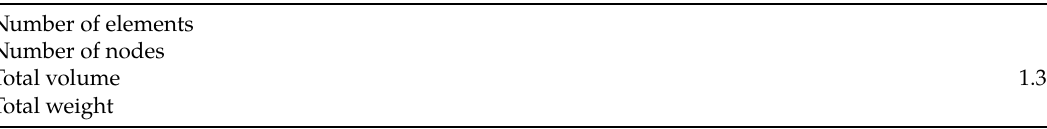
Table 1: Mesh results.